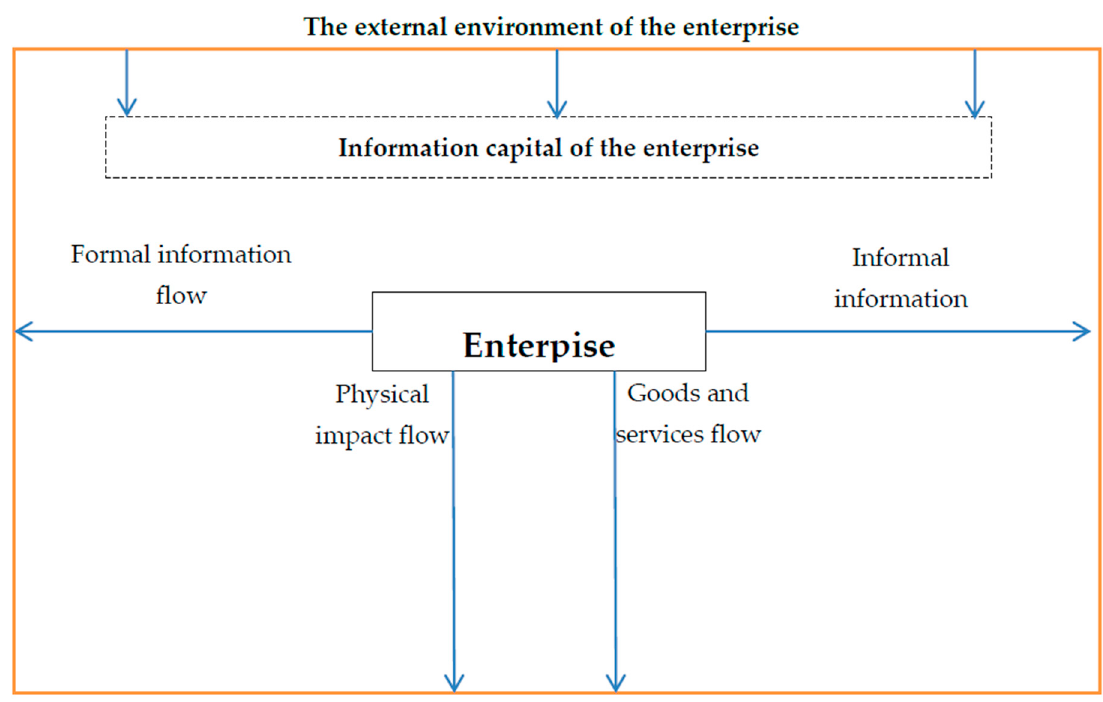
Figure 5. The process of development of information capital. Source: developed by the